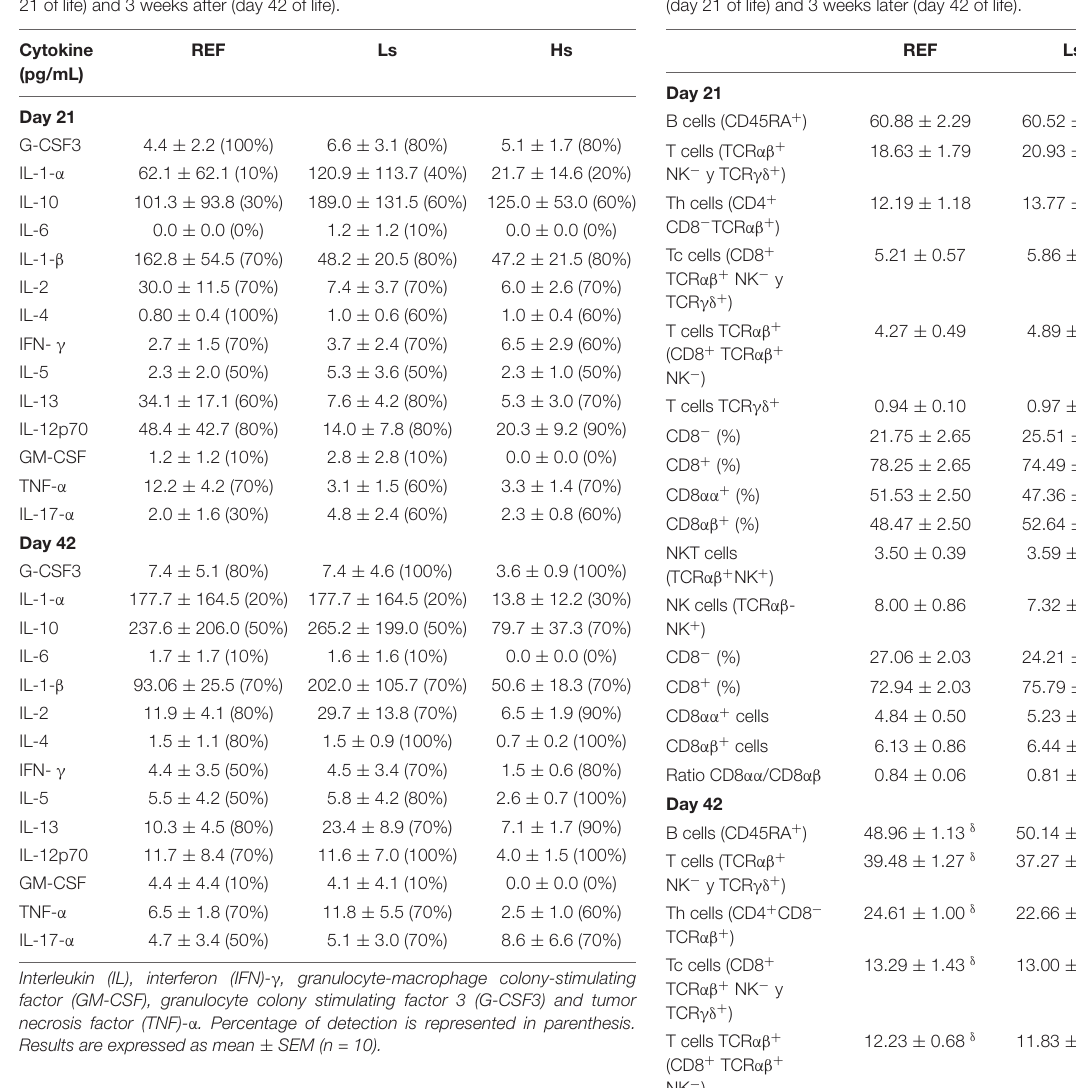
TABLE 3 | Main spleen lymphocyte populations at the end of the supplementation (day 21 of life) and 3 weeks later (day 42 of